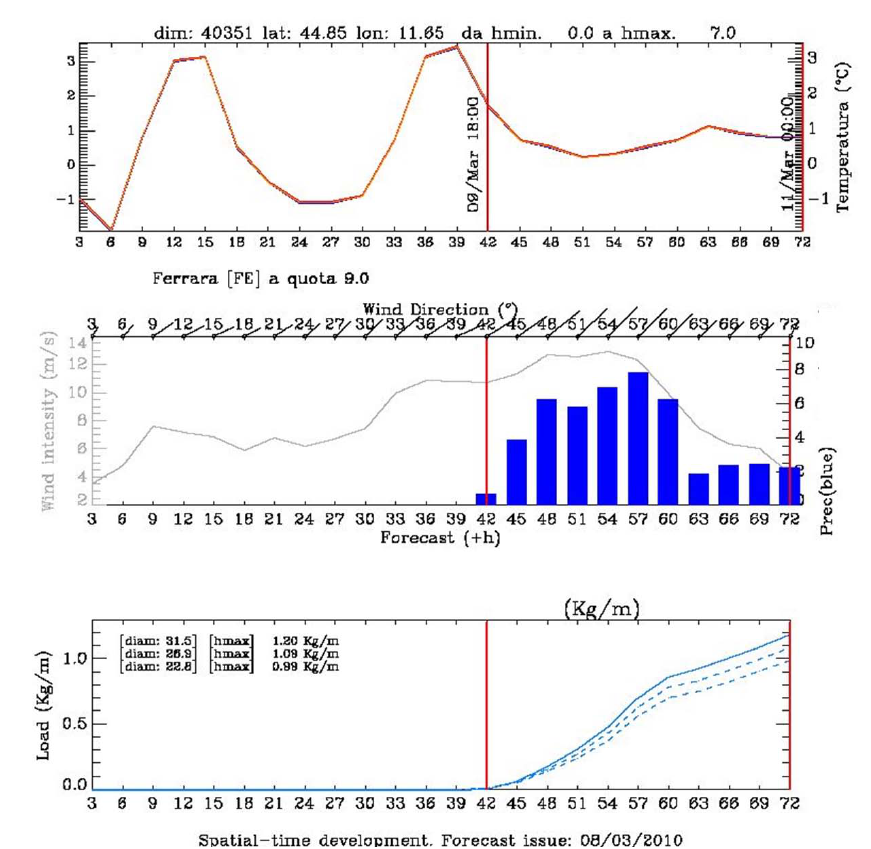
Fig. 6. Time diagram referred to the Ferrara case on 08–10 March